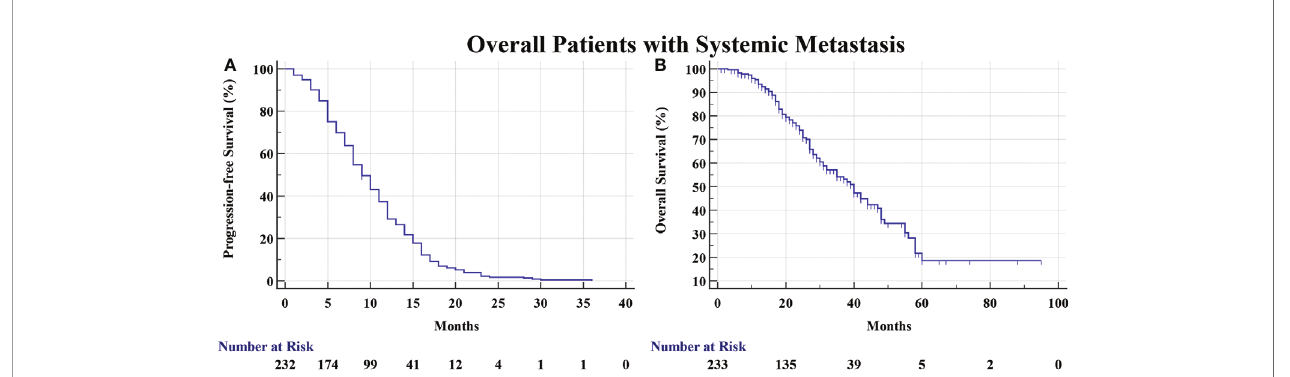
( Table 1 ). The max diameter of primary lung lesion of patients with OP was larger than that of NP (4.3 cm vs . 3.3 cm, p = 0.013).